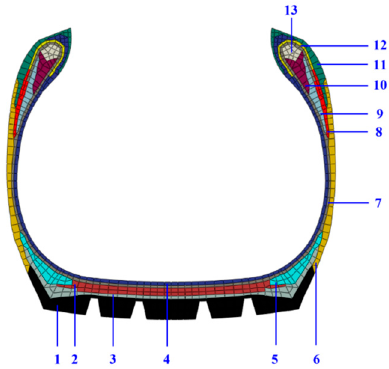
Figure 1. The cross-sectional profile and material distribution of the 12R22.5 TBR tire. (1) tread, (2) belt rubber, (3) under tread, (4) inner liner, (5) shoulder wedge, (6) sidewall, (7) carcass rubber, (8) filler, (9) soft apex, (10) hard apex, (11) abrasion, (12) strength, and (13) bead (steel).